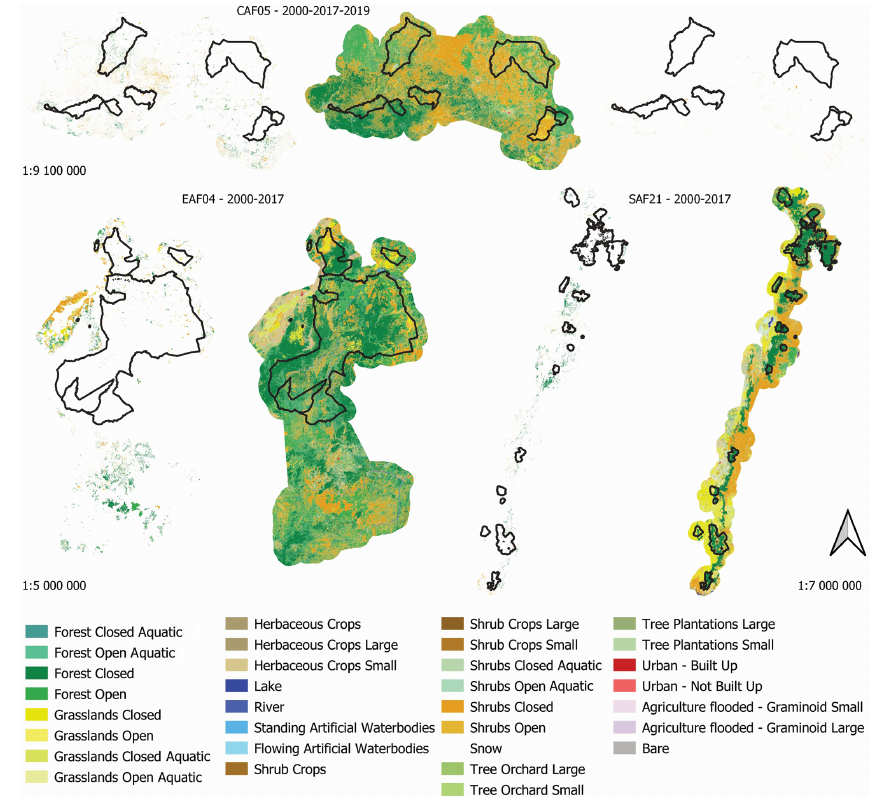
Figure 7. Key landscapes for conservation - modular classification level. The boundaries (black polygons) represent protected areas (IUCN category I–IV – UNEP-WCMC and IUCN, 2021) within the KLCs. Both land cover and land cover change maps are presented for each